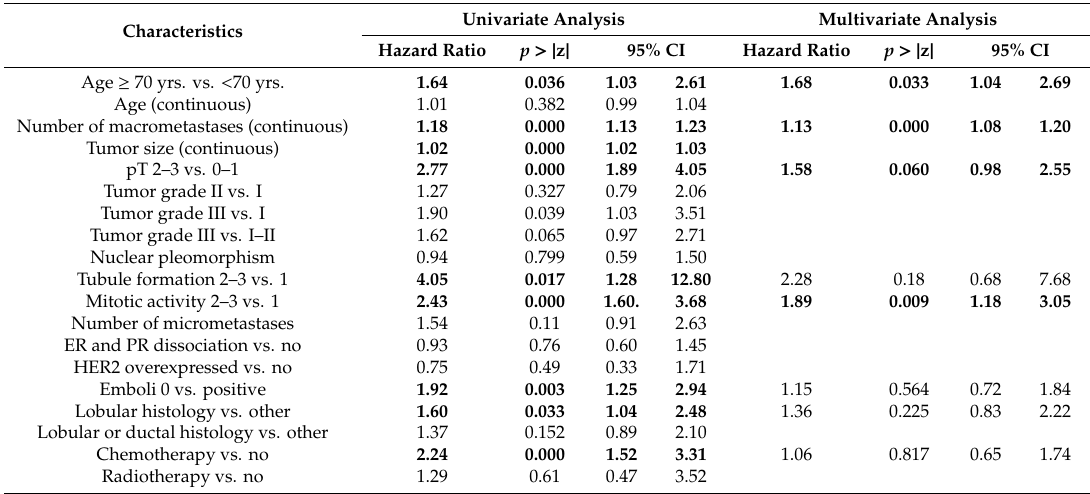
Table 3. Univariate and multivariate analysis of factors associated with late relapse. Characteristics p > | z | 95% CI Hazard Ratio p > | z | 95% CI Age ≥ 70 yrs. vs. < 70 yrs.